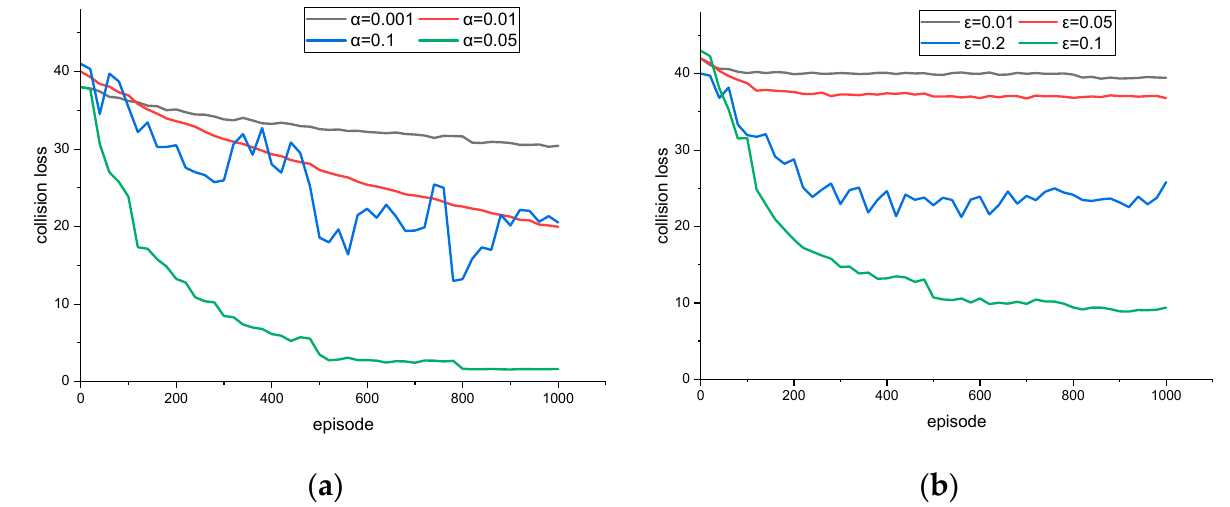
Figure 3. In order to obtain the optimal collision loss strategy that is different from energy loss,